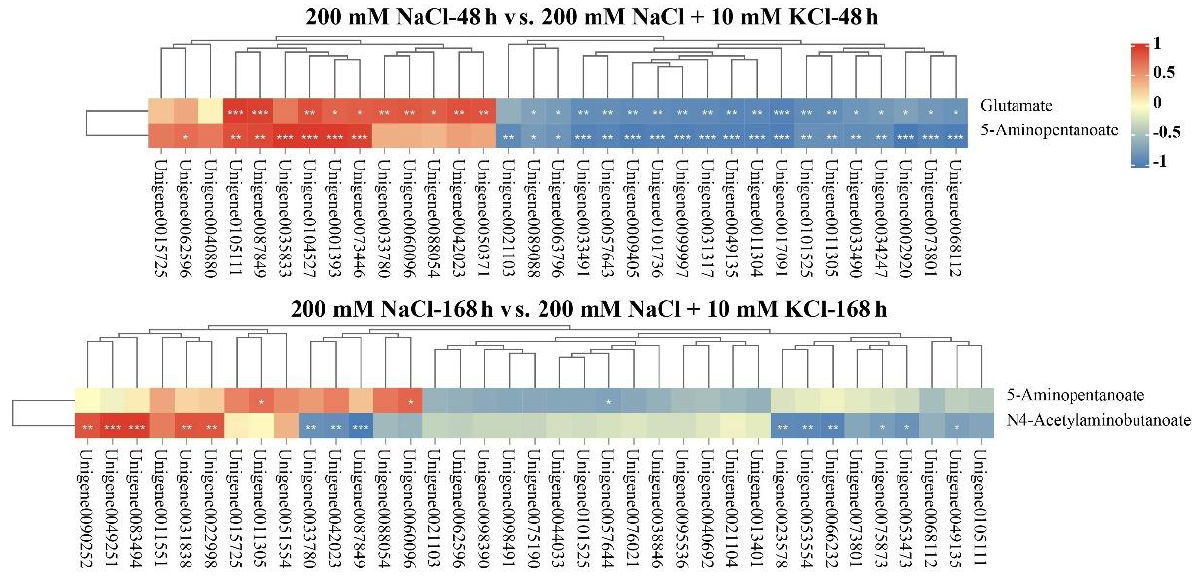
Figure 3. Pearson’s correlation clustering heatmap analysis of DEGs and differential metabolites in the arginine and proline metabolic pathway: The DEGs and differential metabolites contained in Pearson’s correlation clustering heatmap analysis based on the 200 mM NaCl 48 h vs. 200 mM NaCl + 10 mM KCl 48 h and 200 mM NaCl 168 h vs. 200 mM NaCl + 10 mM KCl 168 h comparison groups in the arginine and proline metabolic pathway. Note: p ≥ 0.05 is not marked; * 0.01 < p < 0.05; ** 0.001 < p < 0.01; *** p ≤ 0.001. Table 1. Arginine and proline metabolic pathway.